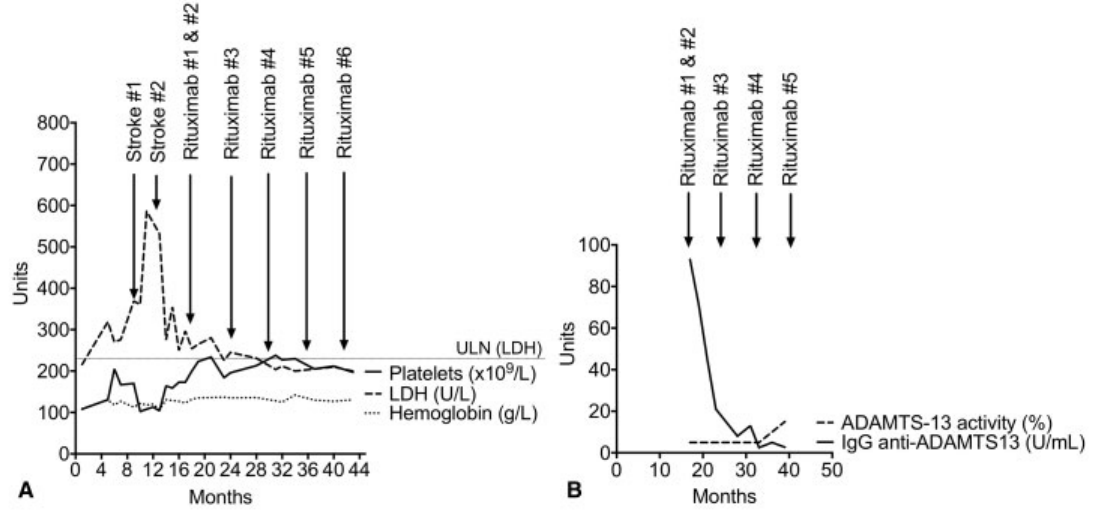
Fig. 1 Evolution of this acquired immune-mediated thrombotic thrombocytopenic purpura. Patient ’ s blood (A) and speci fi c laboratory (B) parameters under rituximab starting in 2015. ADAMTS13, disintegrin and metalloprotease with thrombospondin type-I repeats-13; IgG, immunoglobulin G; LDH, serum lactate dehydrogenase; ULN, upper limit of